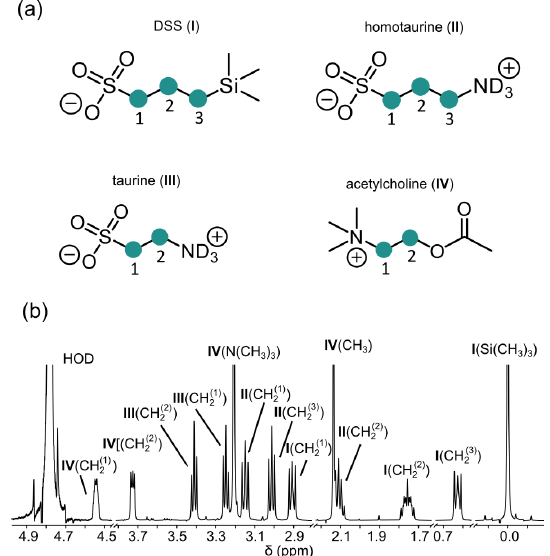
Figure 1. (a) Chemical structures of four molecules support- ing LLSs of CH 2 groups studied in this work: 2,2-dimethyl-2- silapentane-5-sulfonate sodium salt (DSS, I), homotaurine (II), tau- rine (III), and acetylcholine (IV). CH 2 groups supporting LLSs are numbered in each structure and highlighted by green circles. (b) As- signment of the 1 H NMR spectrum of a mixture containing all four